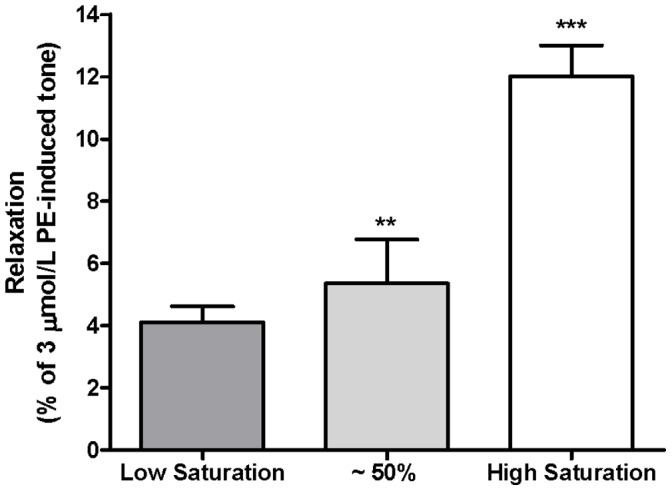
Varying O2 saturations of RBC administered to hypoxic rabbit aortic rings.Partially saturated RBC (∼50%) and low saturated RBC displayed a significantly lower relaxation than RBC of high saturation, **p<0.01 and ***p<0.001 respectively. (High saturation, n = 13; partial saturation, n = 4; low saturation, n = 13).